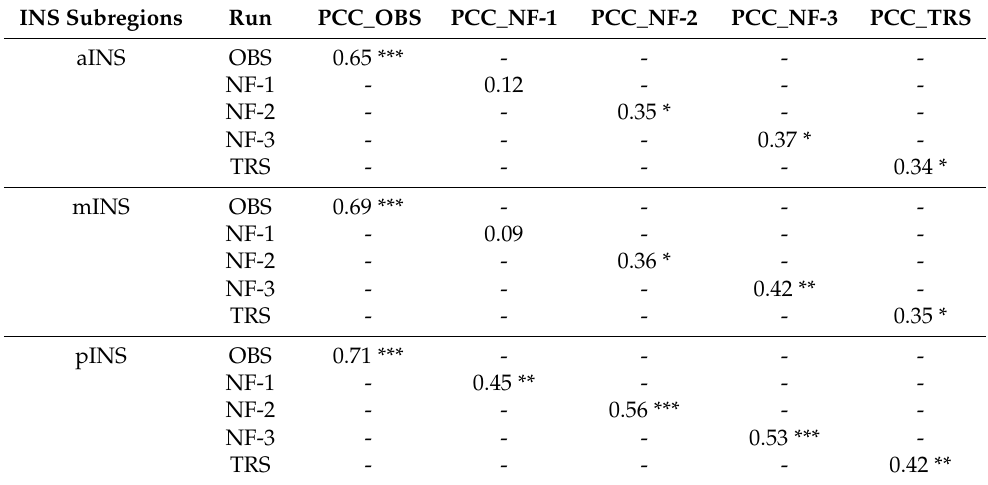
Table 3. Uncorrected correlations between parameter estimate (Focus-on-Breath vs. Describe) in PCC and insula subregions across runs. INS Subregions